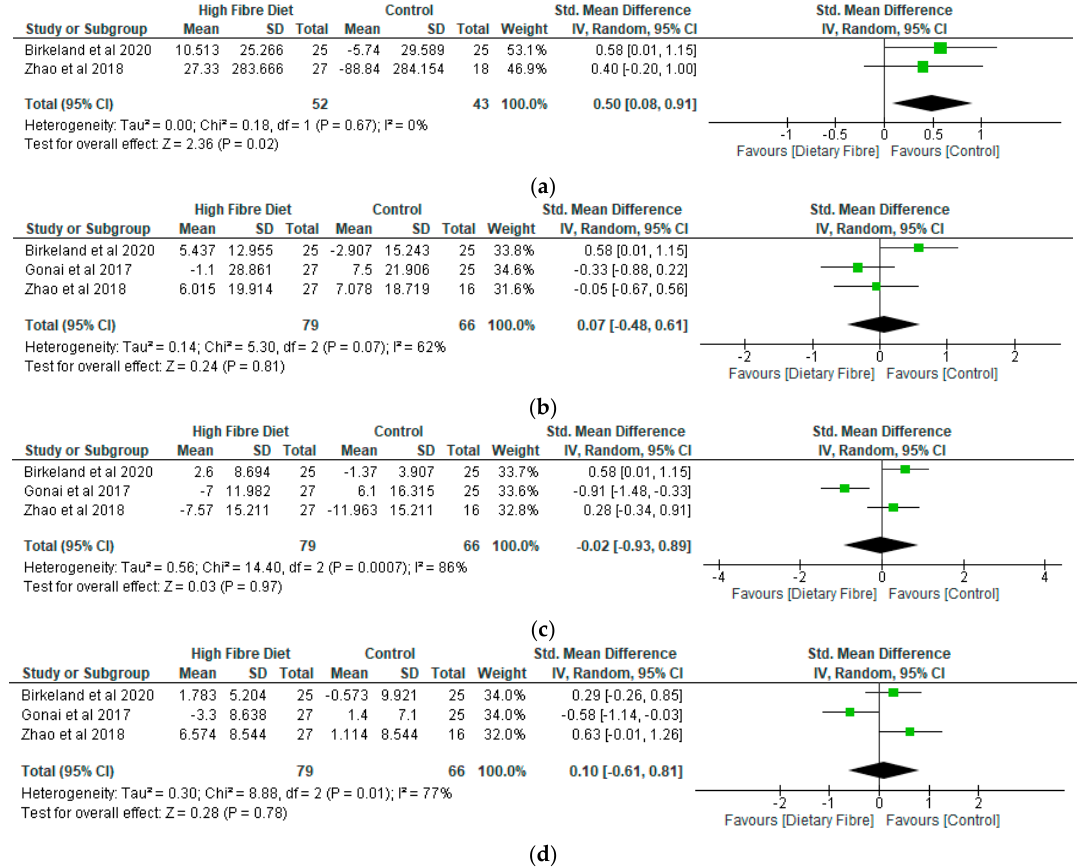
Figure 4. ( a ) The effect of dietary fibre on total short-chain fatty acids. ( b ) The effect of dietary fibre on acetic acid. ( c ) The effect of dietary fibre on propionic acid. ( d ) The effect of dietary fibre on butyric acid.